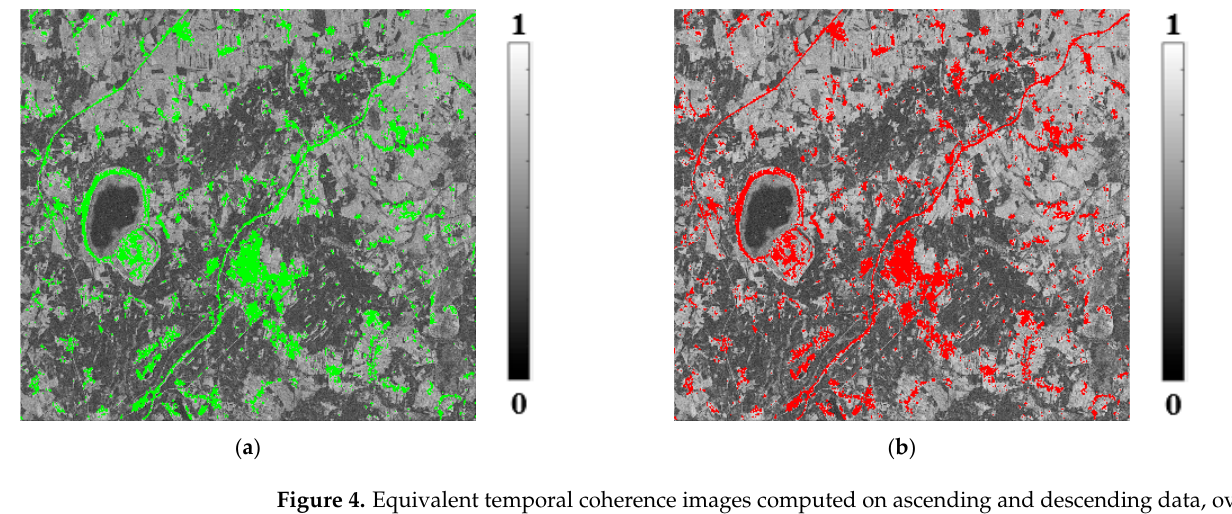
Figure 4. Equivalent temporal coherence images computed on ascending and descending data, overlaid with the points selected with a threshold of 0.8. Vertical axis = azimuth, horizontal axis = range. Descending, full ( a ) and reduced ( b ) interferogram network. The green dots in ( a ) and the red dots in ( b ) represent the selected points using a threshold of 0.8, as associated with the histograms in Figure 5b.